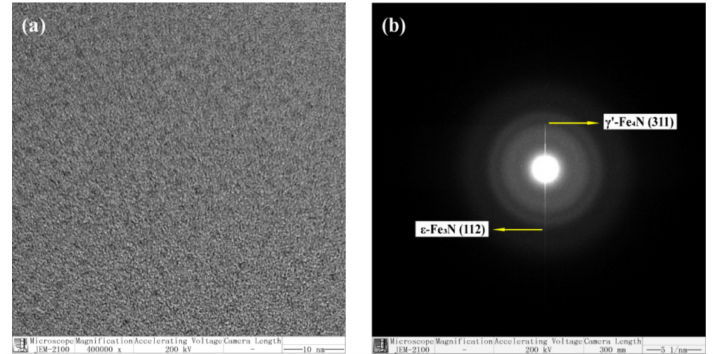
Figure 10. TEM bright field image ( a ) and corresponding SAED pattern ( b ) of surface nanometer layer of modified 3Cr13 steel after RE plasma nitriding for 12